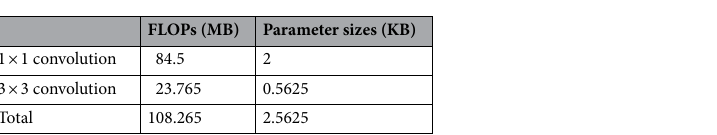
Figure 7. Network of ML-Darknet.